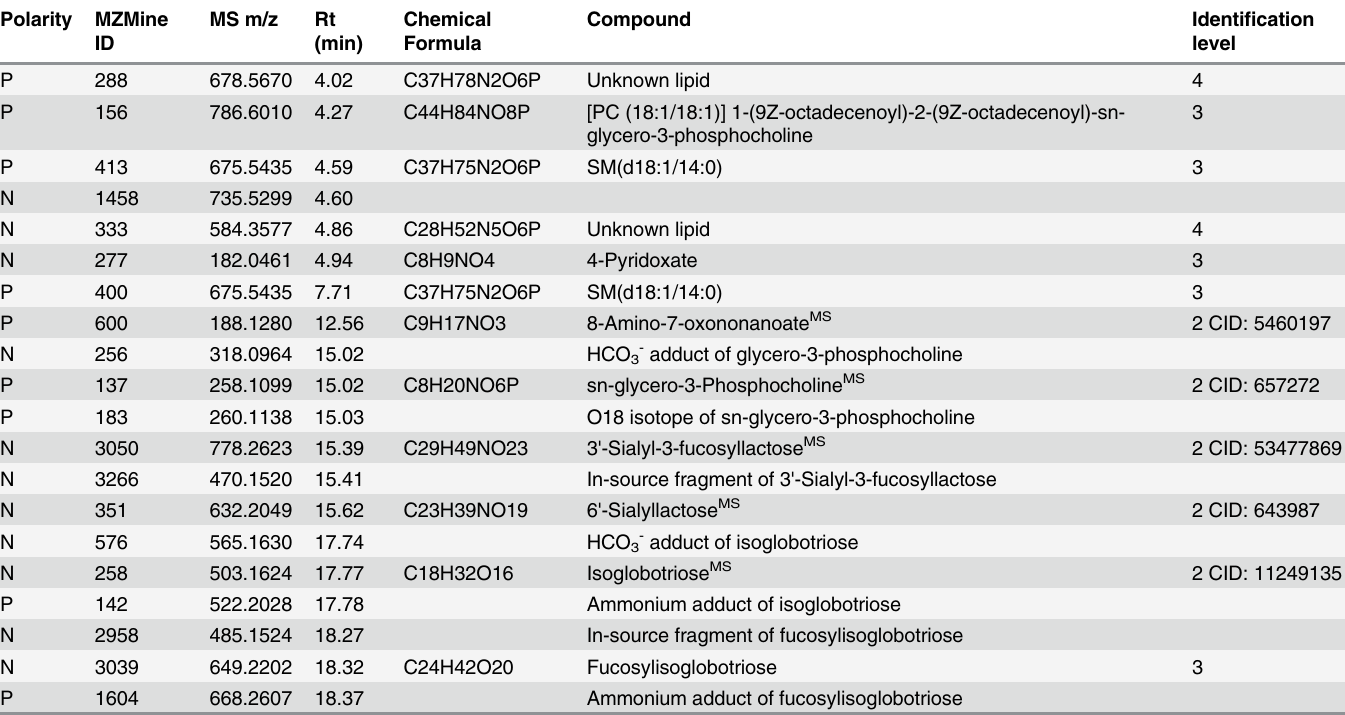
Table 2. The dominant compounds in giant panda milk in Phase 2 and Phase 3 of early